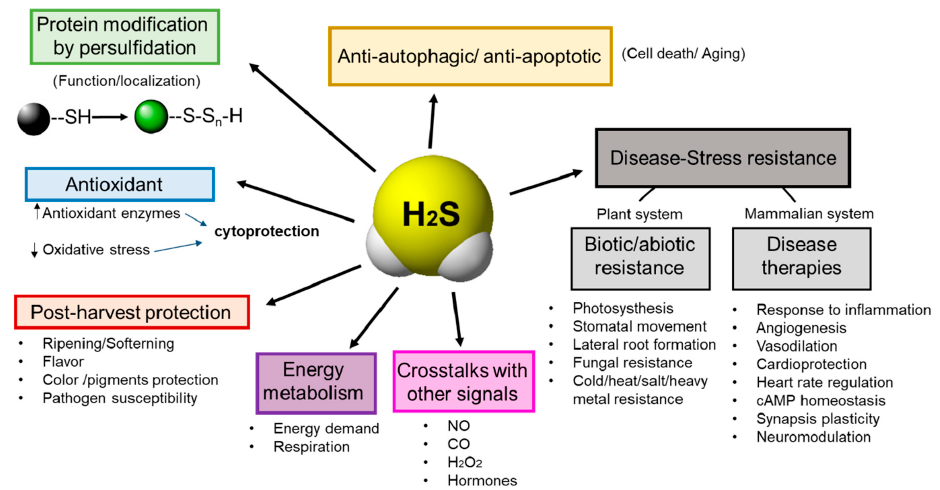
Figure 2. H 2 S is a key activator of multiple physiological processes. H 2 S–mediated signaling ranges from protein modification by persulfidation to affecting a broad range of physiological processes, including regulation of oxidative stress, postharvest protection, disease resistance, autophagy signaling, energy metabolism regulation and crosstalk with other signaling